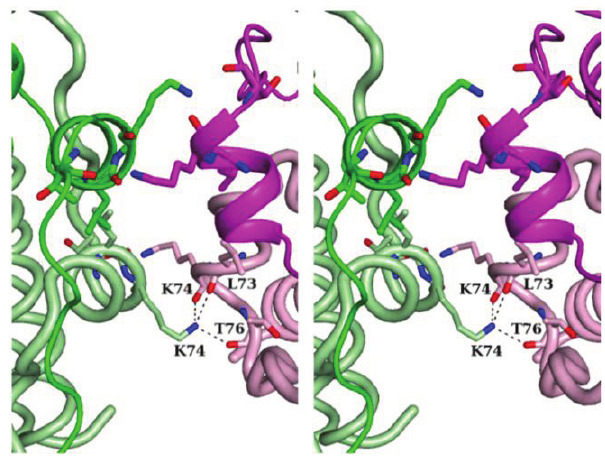
Figure 3. Stereo-representation of the molecular contacts between two neighboring dodecamers in Fe-loaded HP-NAP YS39. The Lys74 N ζ atom is hydrogen-bonded to the backbone O atoms of Leu73, Lys74, and Thr76 of the neighboring dodecamers.